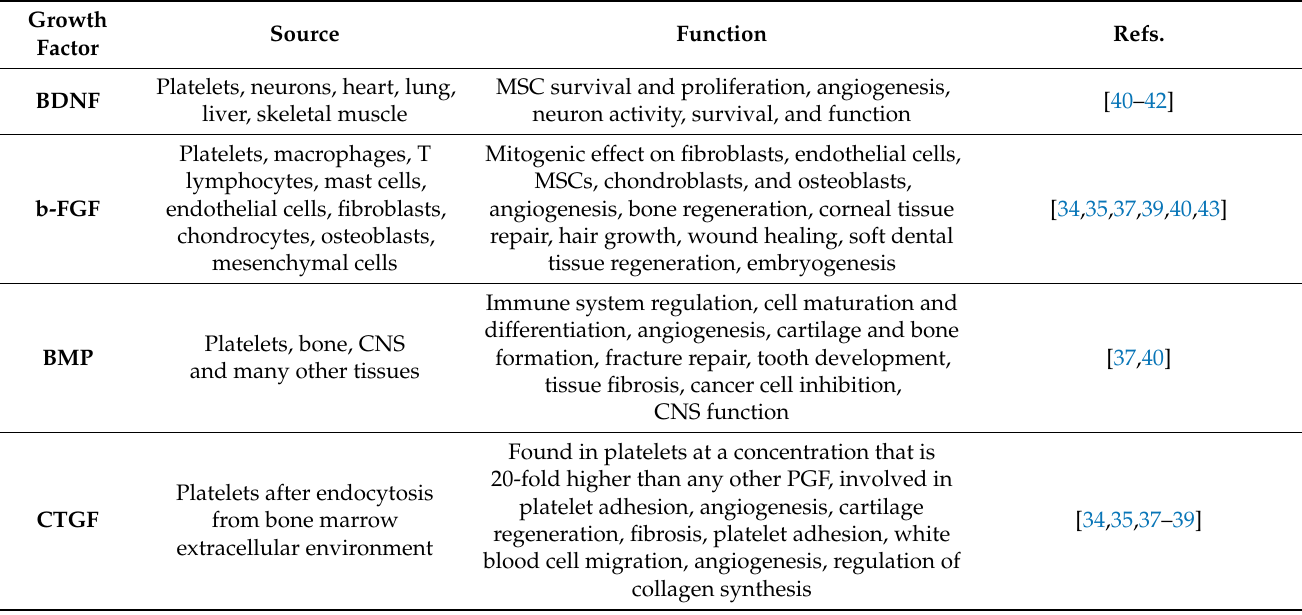
Table 1. Growth factors released by platelets or identified in platelet